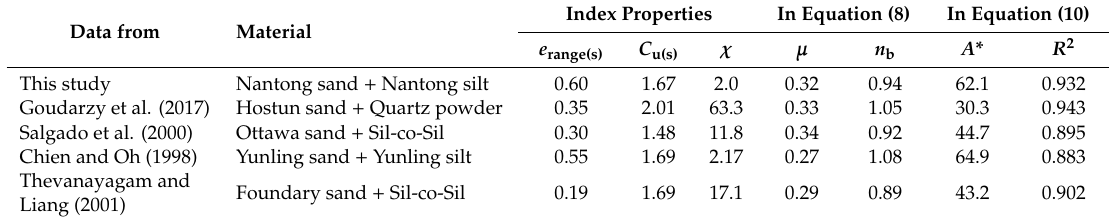
Table 4. Physical index properties and fitting parameters of silty sands considered in this